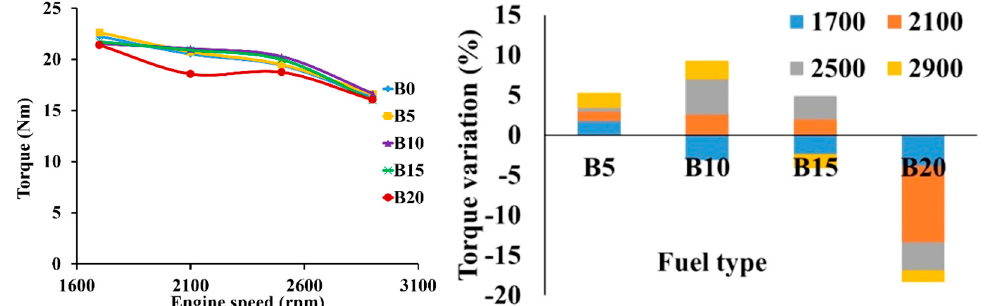
Figure 5. Variation of engine torque (kNm) for different engine speeds and diesel biodiesel blends at full load.